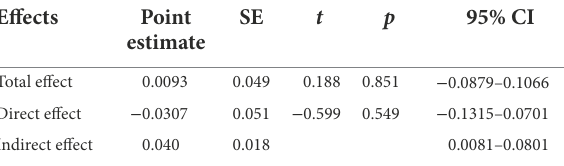
TABLE 5 Total, direct and indirect effects of COVID-19 stress on satisfaction with life through COVID-19 transmission misinformation.